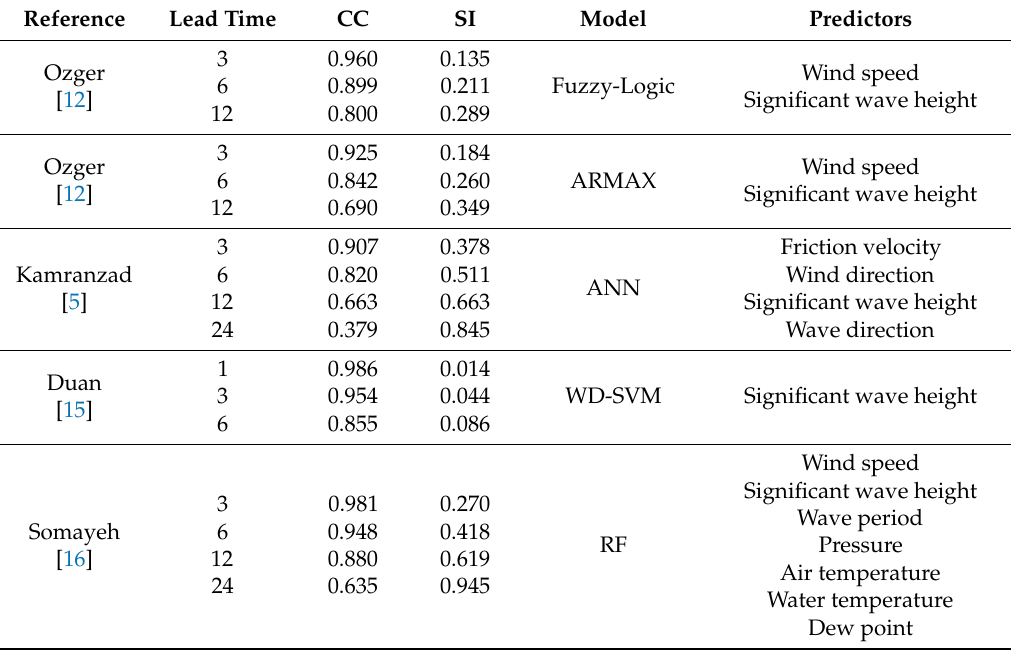
Table 13. The predictions of di ff erent methods and di ff erent input predictors.